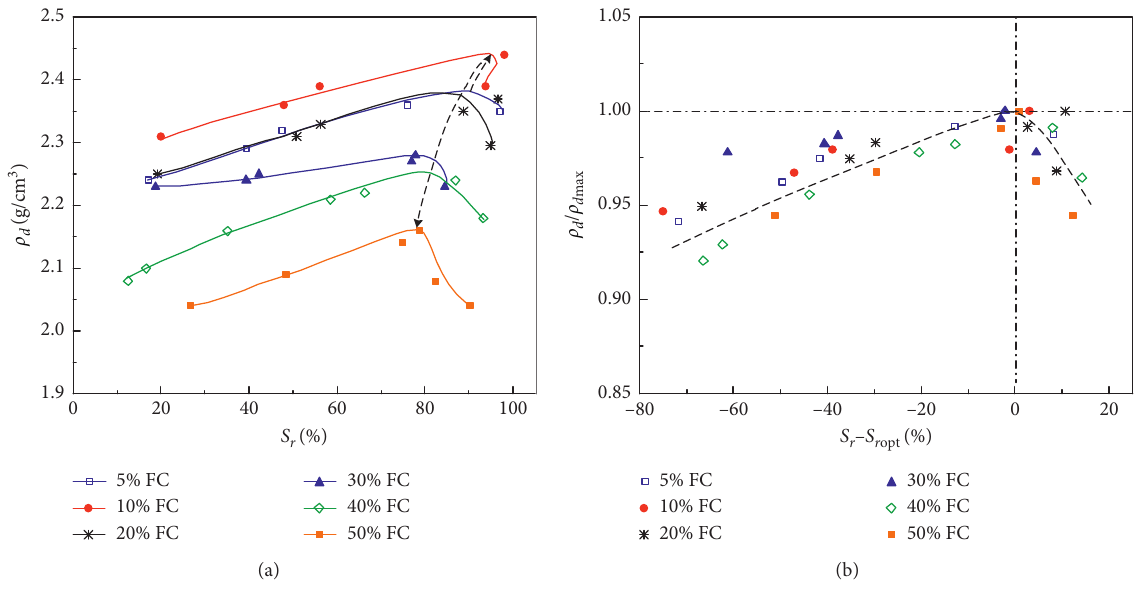
Figure 6: Compaction curves plotted in terms of saturation degree: (a) dry density ρ against S r − S r opt